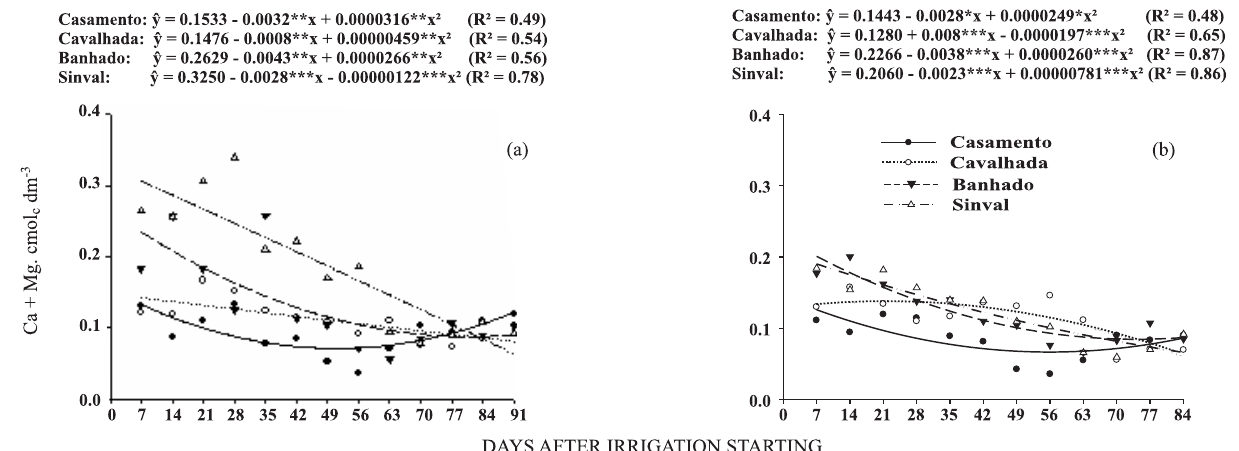
Figure 6. Calcium + magnesium concentration in the water layer (a) and irrigation water (b), at the different sites. *, **, ***: significant at 10, 5 and 1 %, by the F-test,